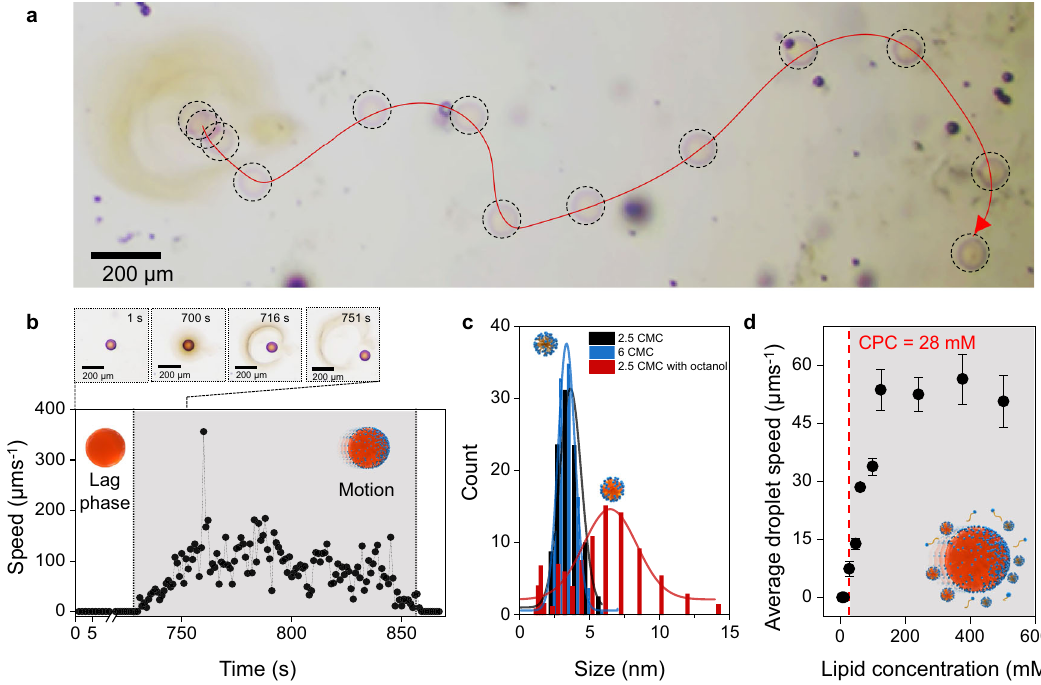
Fig. 2 Emergence of droplet motility from lipid reproduction. a Trajectory of an octanol droplet tracked over 80 s (Supplementary Movie 3). All octanol droplets moved in these experimental conditions. b Speed of an octanol droplet over time (individual trace, diameter of the droplet is 100 µ m). The appearance and expansion of a corona occurred during the lag phase for all studied droplets. c Dynamic light scattering data showing the size of aggregates formed by lipid 1 at 2.5 times and 6 times the critical micellar concentration (CMC = 21 mM), and in the presence of octanol droplets, in a solution of lipid at 2.5 times the critical micellar concentration. d Average speed of a 50 µ m octanol droplet for increasing concentrations of lipids in the reaction medium. Each point is an average of fi ve droplets, and the error bars indicate standard deviation. The droplets move only when the lipid concentration reaches above CPC (~ 28 mM for 50 µ m